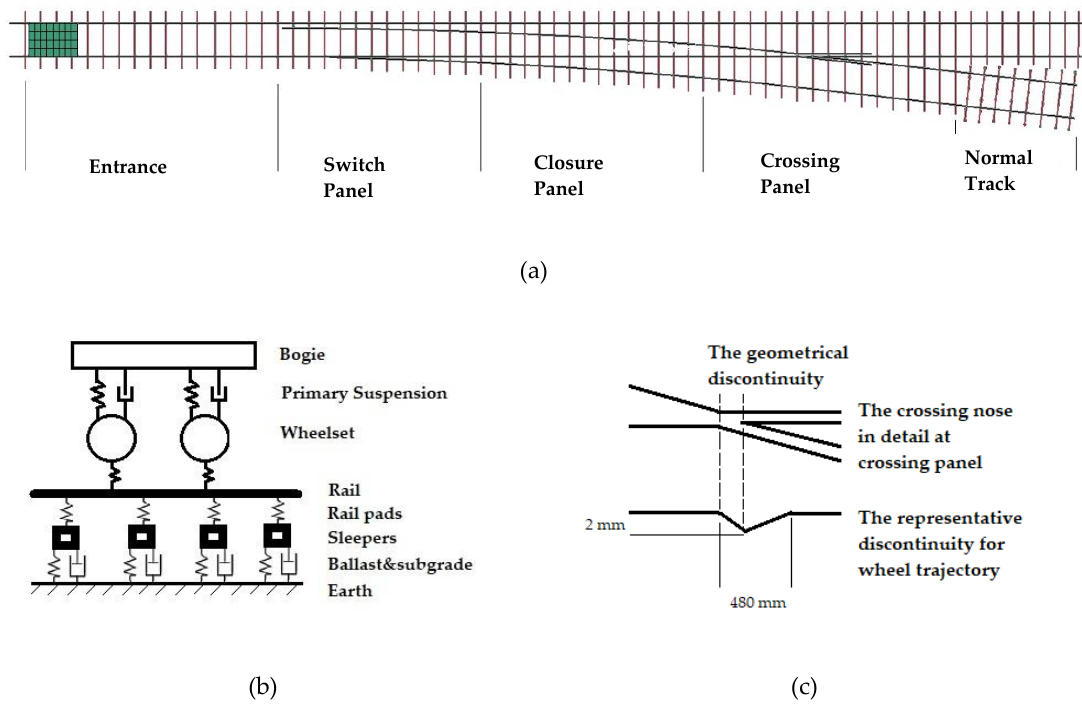
Figure 1. The Finite Element Method (FEM) model. ( a ) The layout of a standard turnout; ( b ) the schematic vehicle-track couple; and ( c ) the crossing nose and wheel trajectory.